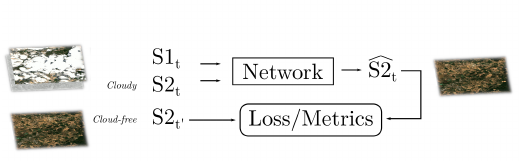
Figure 3. SSOP network. S 1 t and S 2 t denotes the input pair of Optical and SAR images acquired at date t . The S 2 t (cid:48) denotes the reference image used to compute the loss (during training) and the metrics (at inference time from test data) from the reconstructed optical image (cid:100) S 2 t . Figure 4. Proposed architecture for encoder ( E ) and decoder ( D ), enabling the use of inputs of different resolutions. First and last convolutions use a unitary stride and a kernel of size